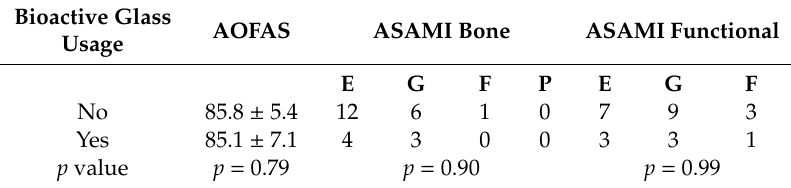
Table 5. Comparison between the results of bioactive glass usage using the AOFAS and ASAMI Bone and Functional Scoring